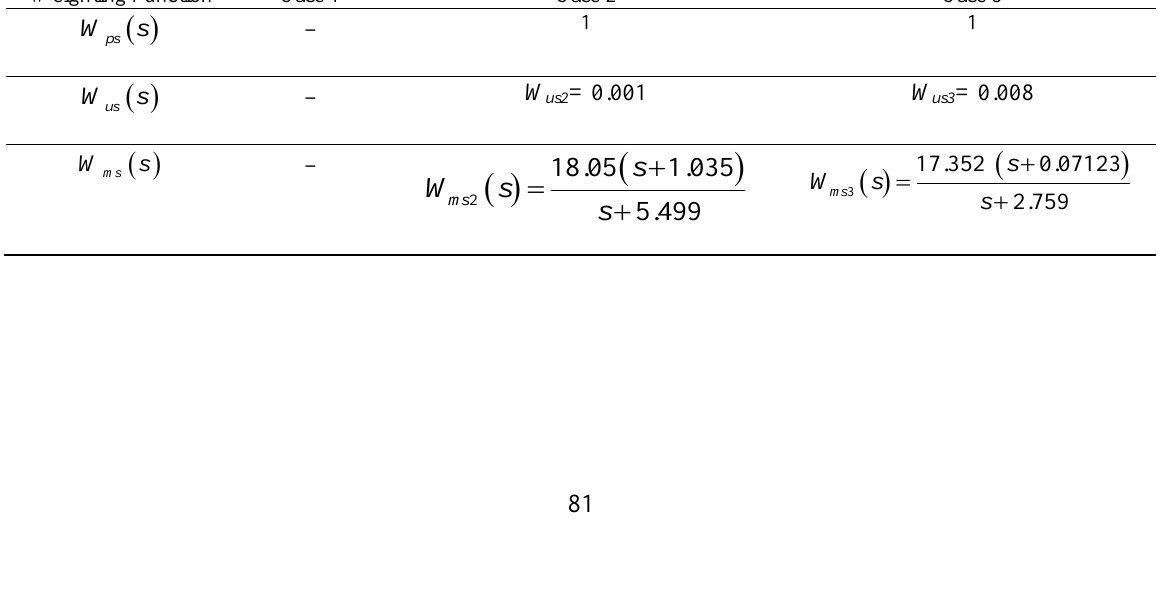
Table 2. Corresponding weighting function for local slave controller design shown in Figure 5 Weighting Function Case 1 Case 2 Case